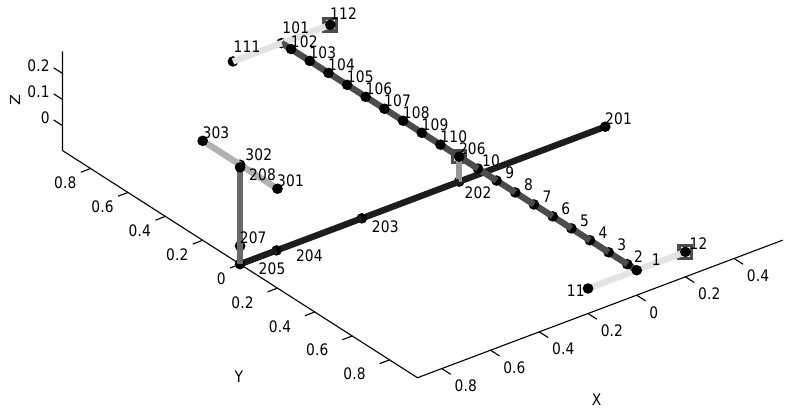
Fig. 5. Initial FE model of the GARTEUR SM-AG19 structure: 35 nodes ( • ), 34 beam elements, 3 lumped masses ( ), 210 DOFs.